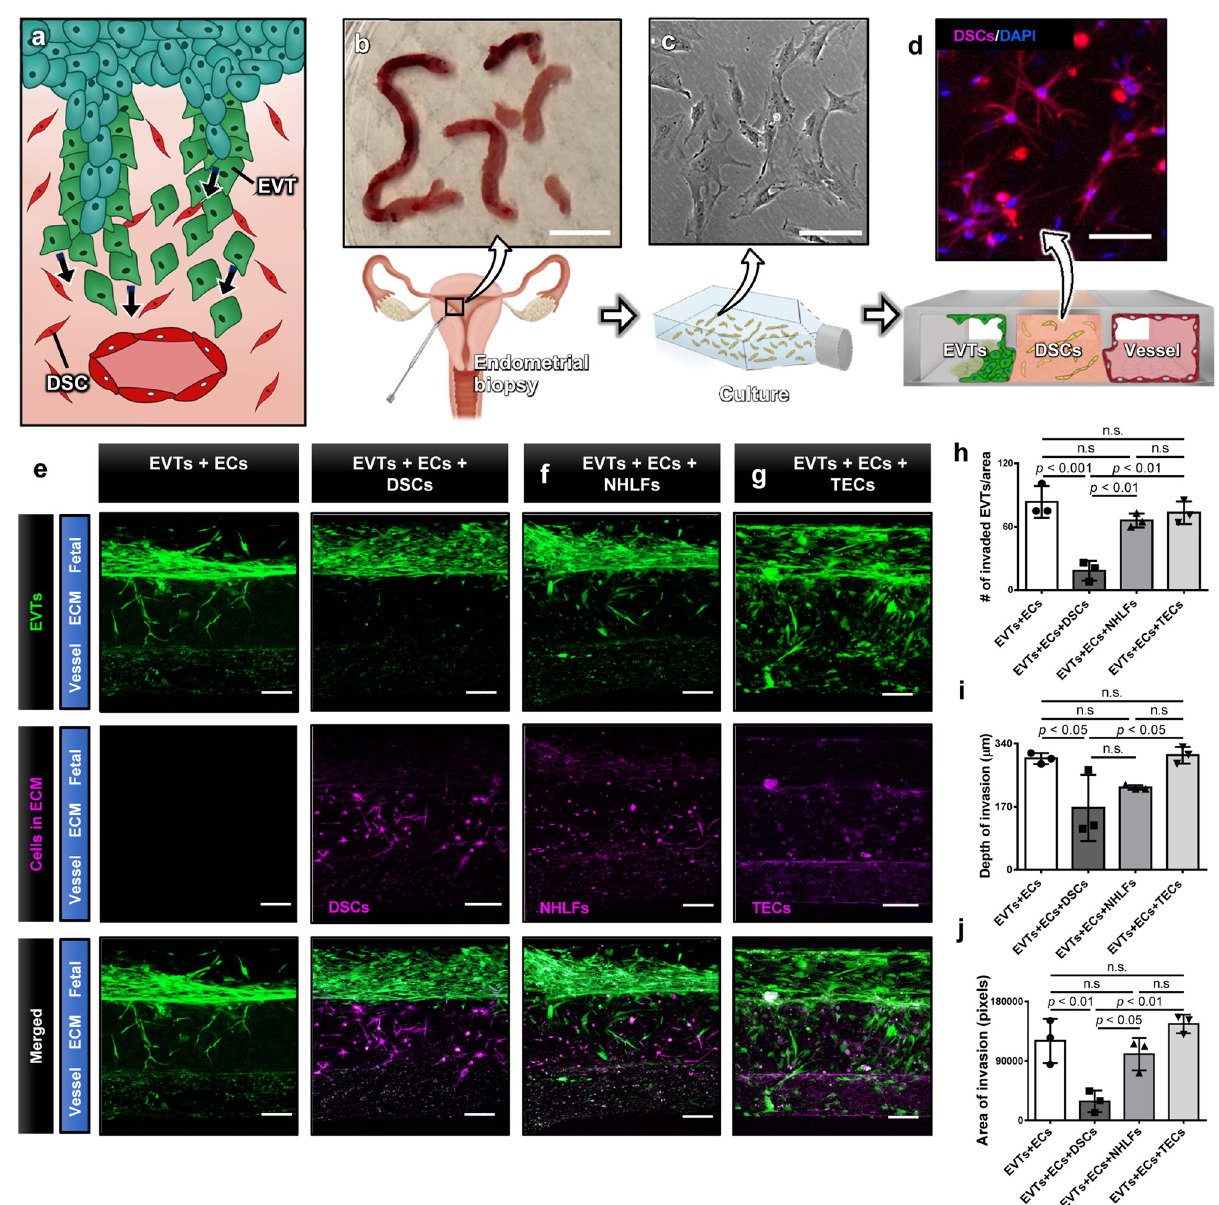
Fig. 5 Effect of decidualized stromal cells on EVT invasion. a During invasion, fetal EVTs encounter DSCs and interact with them. b Primary human DSCs were isolated from pre-pregnancy endometrial biopsies taken during the window of implantation. Scale bar, 1 cm. c Isolated DSCs were cultured in a fl ask prior to seeding into the ECM compartment of the implantation-on-a-chip device. The representative image is from three independent experiments. Scale bar, 100 μ m. d A micrograph of DSCs (magenta) in the hydrogel. Cell nuclei were stained with DAPI (blue). The representative image is from three independent experiments. Scale bar, 100 μ m. e Comparison of EVT migration towards ECs in the absence (left colum) or presence (right colum) of DSCs. Scale bars, 200 μ m. Tissue-speci fi city of the observed effects was investigated by replacing DSCs with f NHLFs and g TECs in the ECM compartment. The representative images of (e-g) are from three independent experiments. h – j Quanti fi cation of EVT invasion under different combinations of cultured cells. Data are presented as mean ± SD. One-way ANOVA with Tukey ’ s multiple comparison test ( n = 3 independent devices per group). p values are shown on graphs. DSCs, Decidual stromal cells. NHLFs: Normal human lung fi broblasts, TECs: Tracheal epithelial cells Source data are provided as a Source Data fi